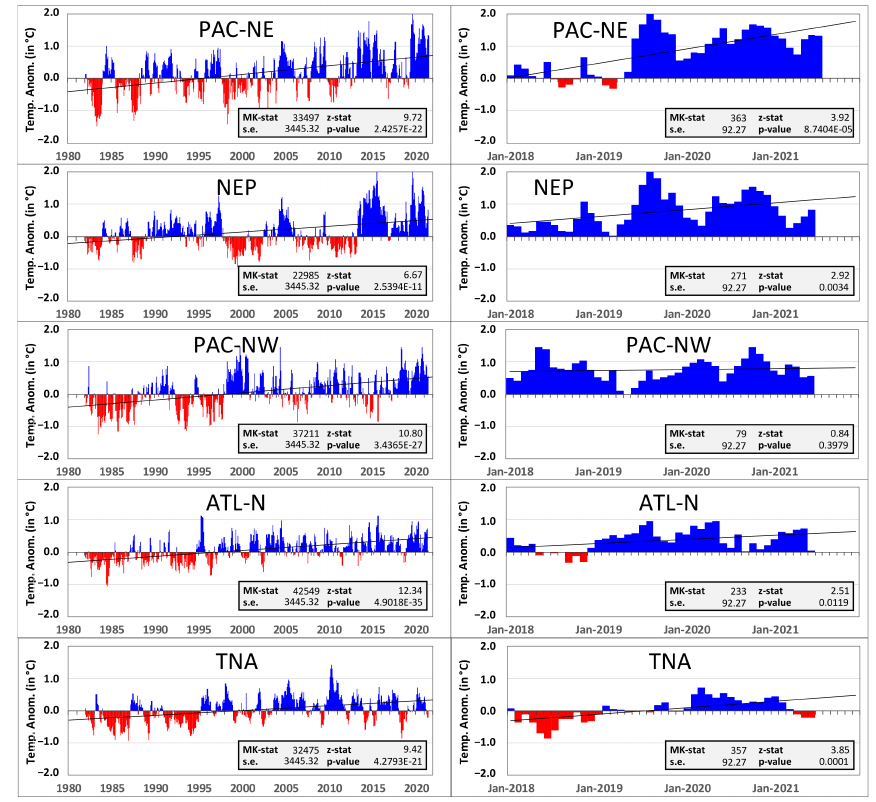
Figure 9. Sea Surface Temperature Anomalies (SSTA) for series January 1982/June 2021 at oceanic regions PAC-NE —Pacific Northeast, PAC-NW —Pacific Northwest and ATL-N —Atlantic North (see Figure 2). Anomalies are estimated from the monthly mean values of the series